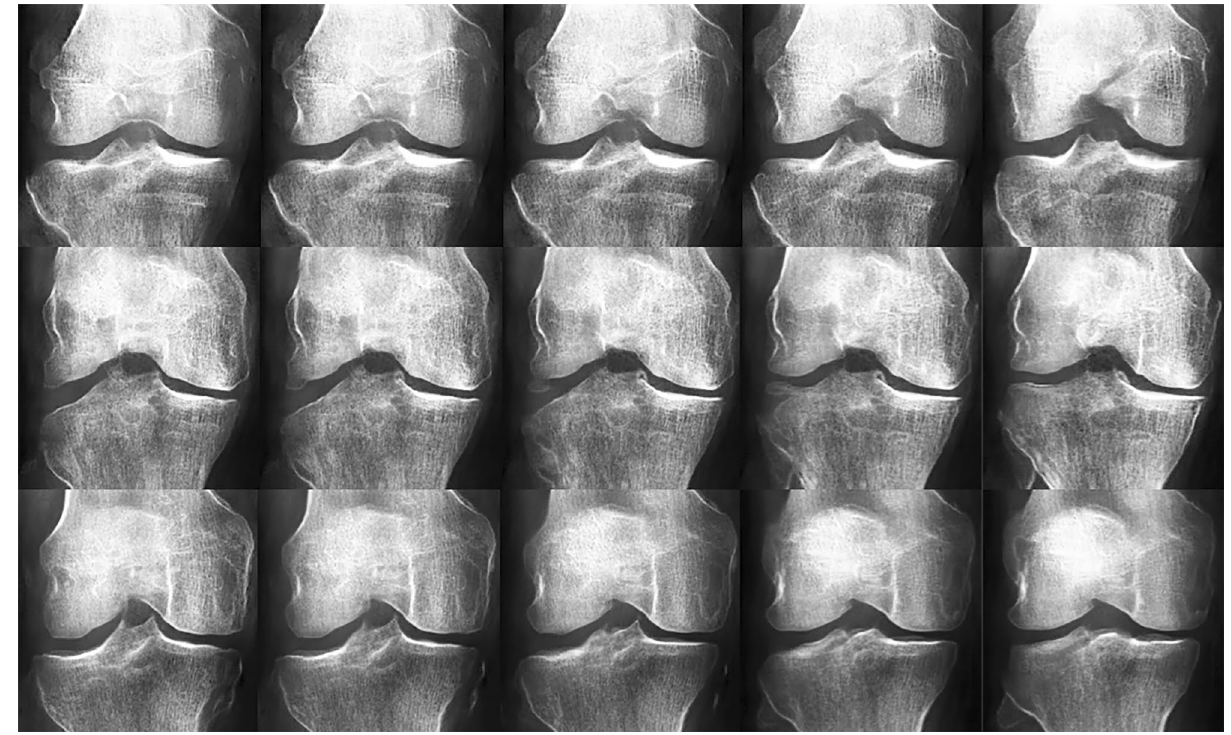
Figure 4. Latent dimension perturbations are displayed. The first two rows show changes in one latent dimension. Left to right for positive change, and vice versa for negative change. The last row showcases linear interpolation between two X-ray latent space coordinates at the extremes of the